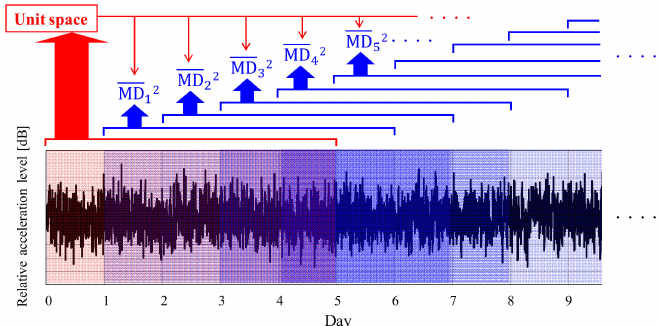
Figure 25. Calculation of MD 2 for each day in the 870-day simulation: By using the time-series data of the first five days, the unit space is generated. Next, the 50,460 values of MD 2 for the five days beginning on the second day were calculated as MD 12 . This operation is performed in the same manner for all of the data of 870 days.